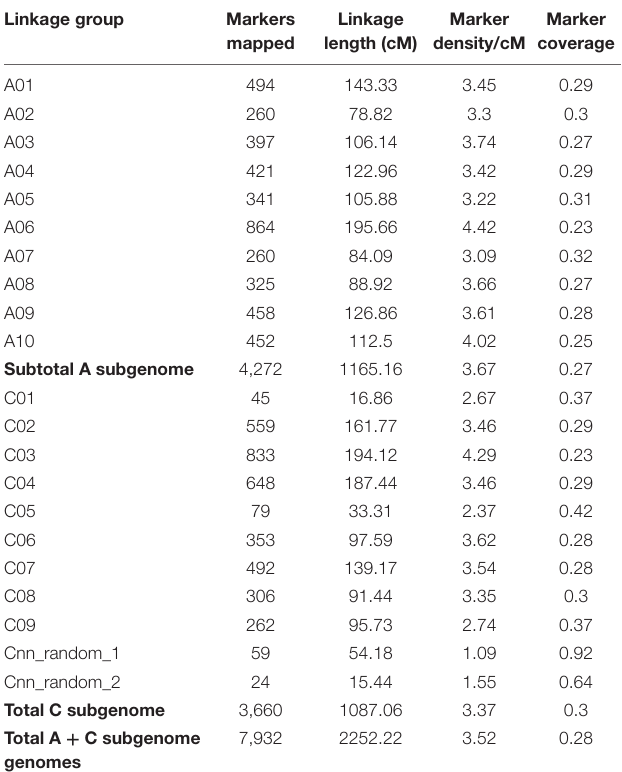
TABLE 1 | Linkage map of the CB-Telfer/Ag-Cobbler population constructed using DArTseq